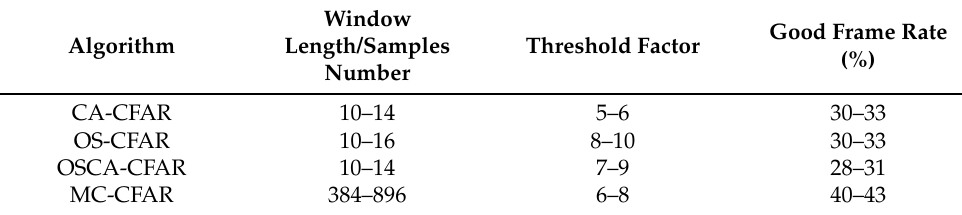
Table 3. Radar system